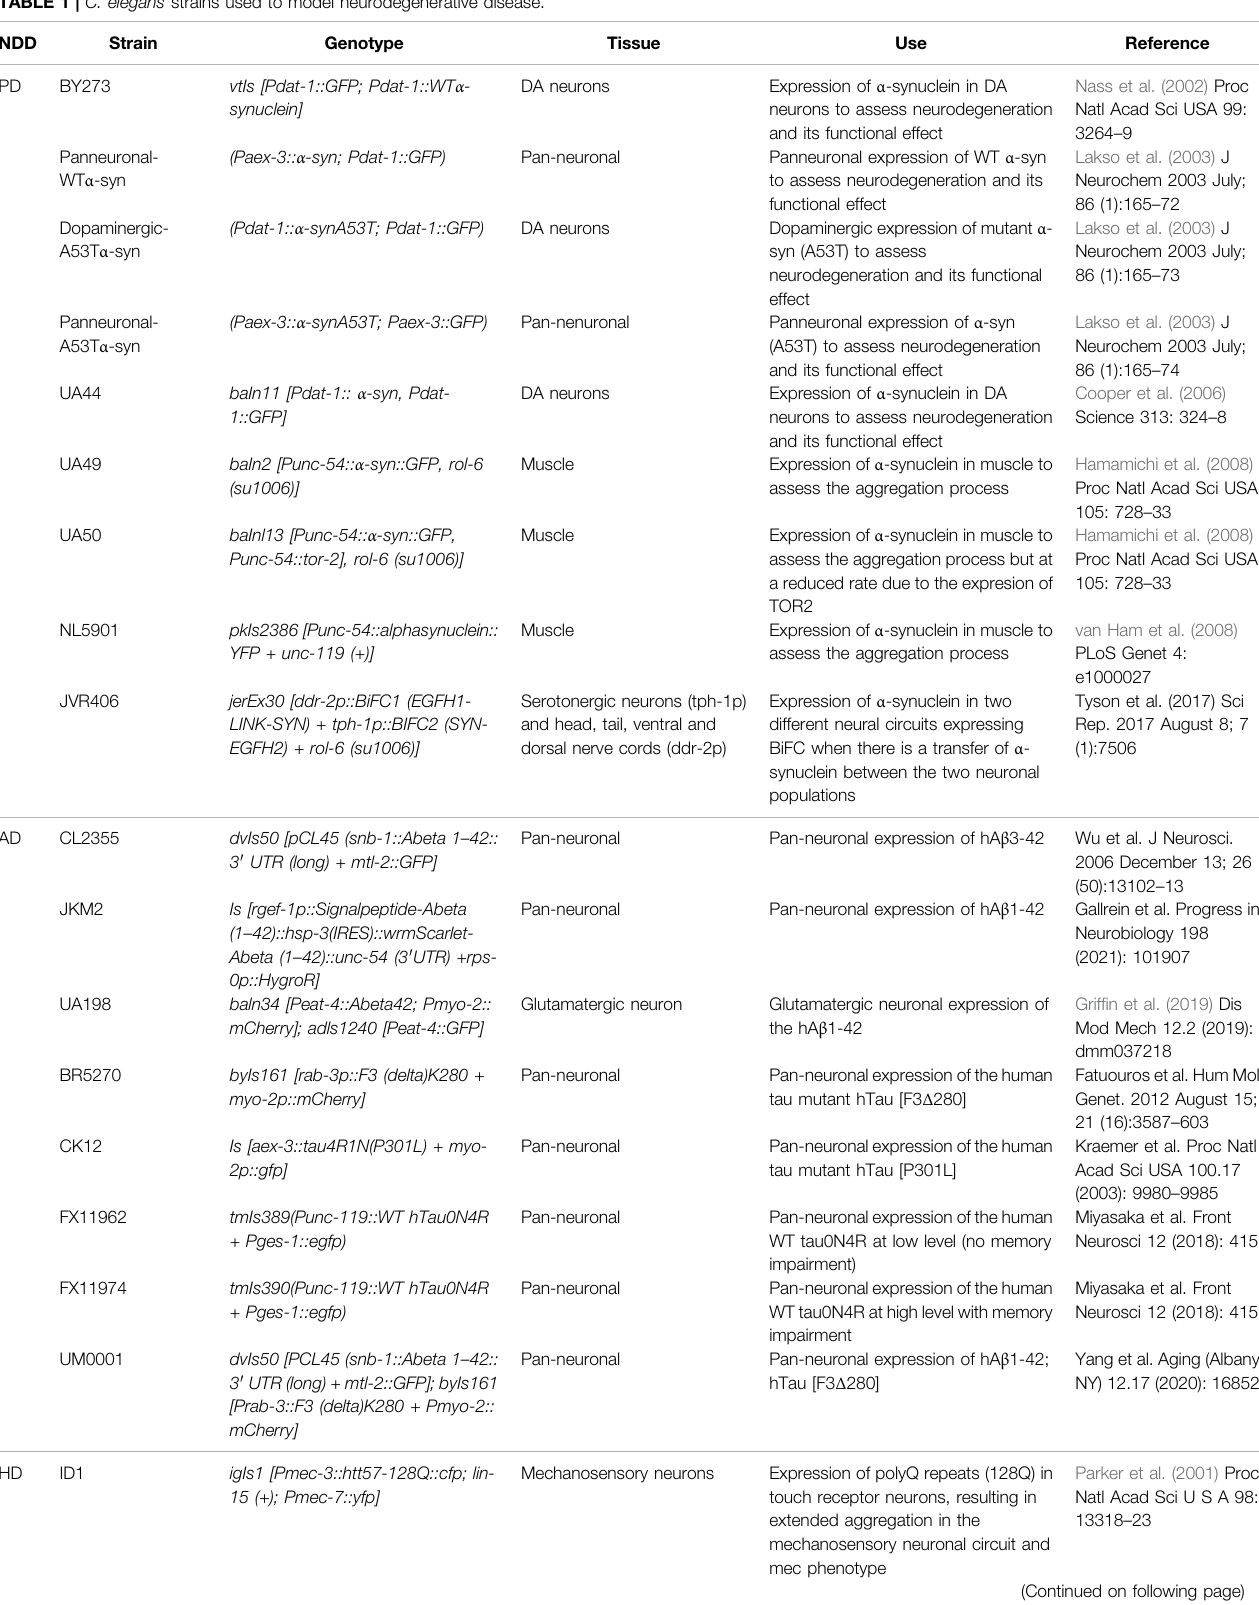
TABLE 1 | C. elegans strains used to model neurodegenerative